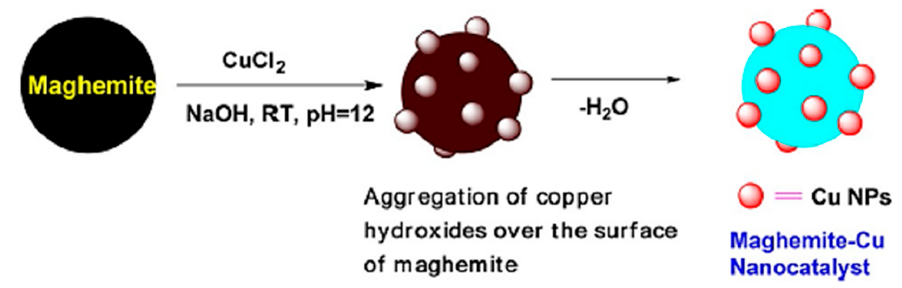
Figure 5. Synthesis of maghemite-Cu nanocatalyst. Reproduced by permission of Wiley [51]. Catalysts 2020 , 10 , x FOR PEER REVIEW 12 of 51